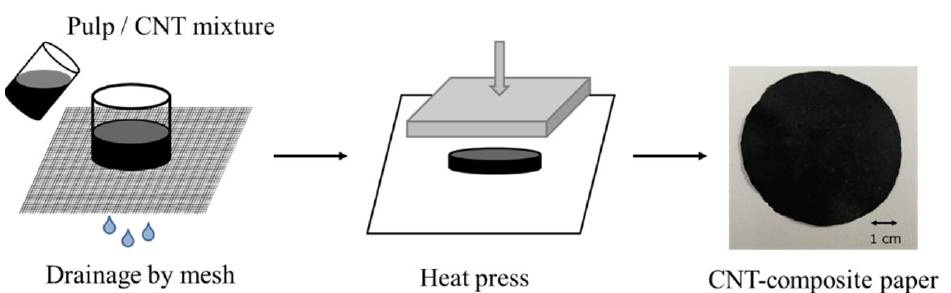
Figure 10. Process for making CNT-composite paper.